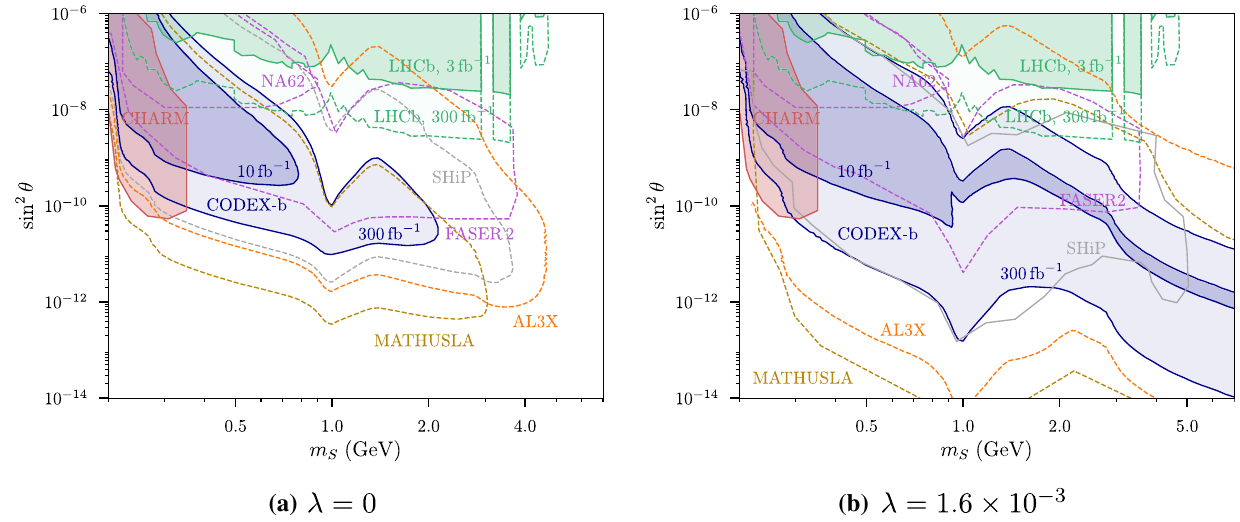
Fig. 9 Reach of CODEX-b as a function of sin θ , for two representative values of λ . The MATHUSLA reach is shown for its 200 m × 200 m configuration for 3 ab − 1 ; for AL3X 100 fb − 1 of integrated luminosity was assumed